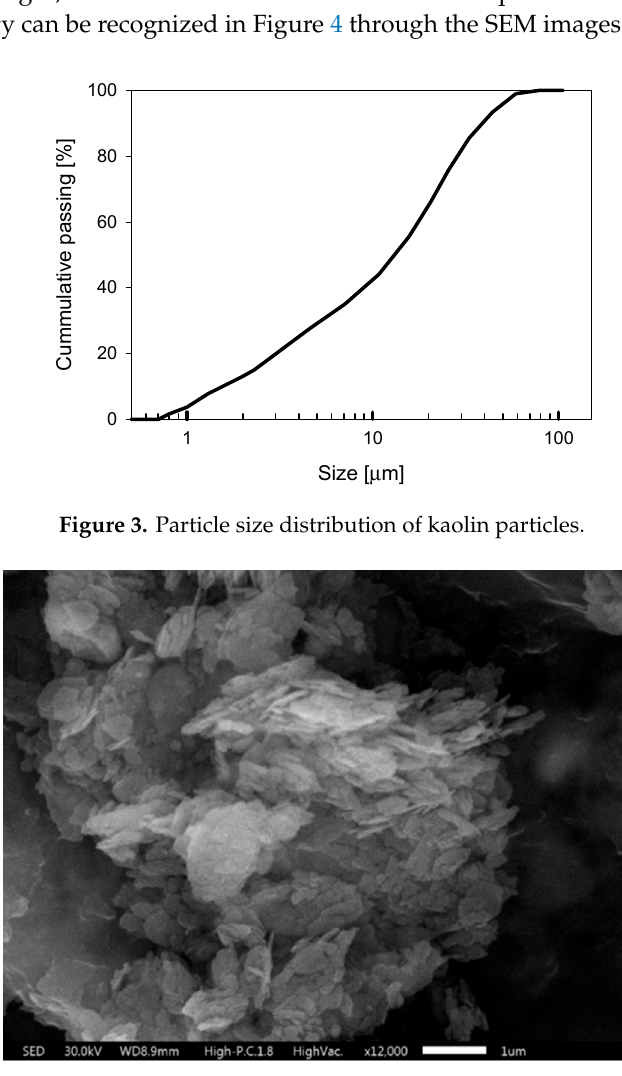
Figure 4. High-resolution SEM image showing surfaces of kaolin mineral.